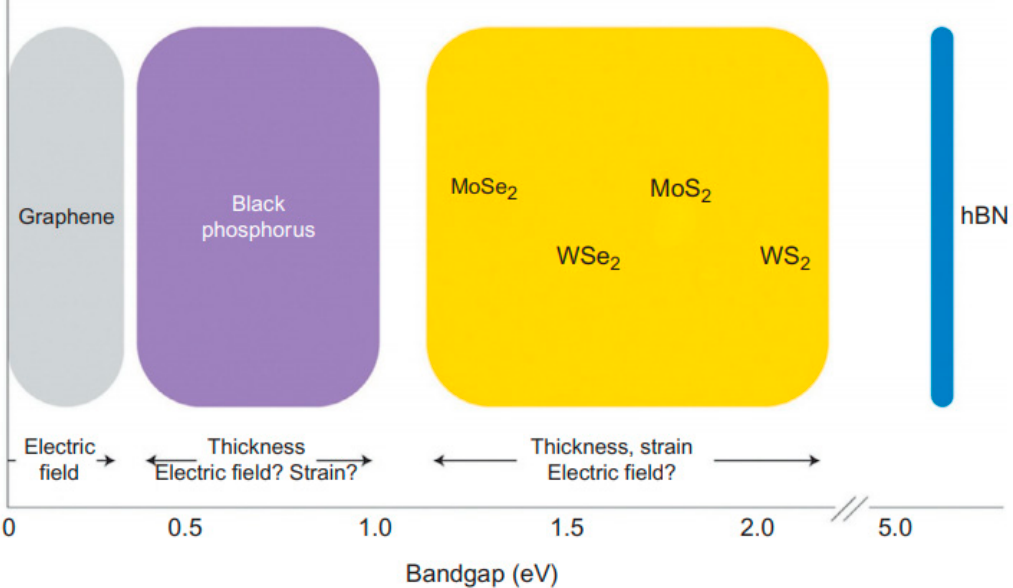
Figure 4. Bandgap energies of several layered materials used for nanoelectronics. (Reprinted with permission from [41]. Copyright (2015), Elsevier.)